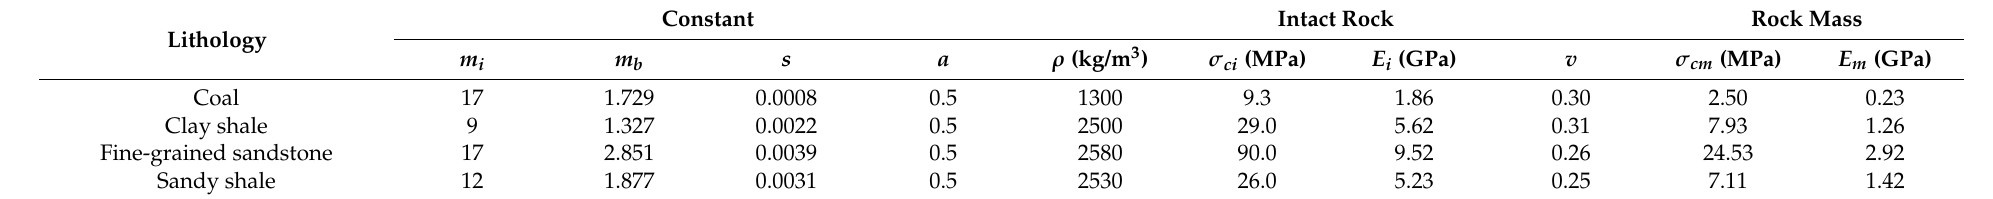
Table 2. Physical and mechanical parameters of rock masses.